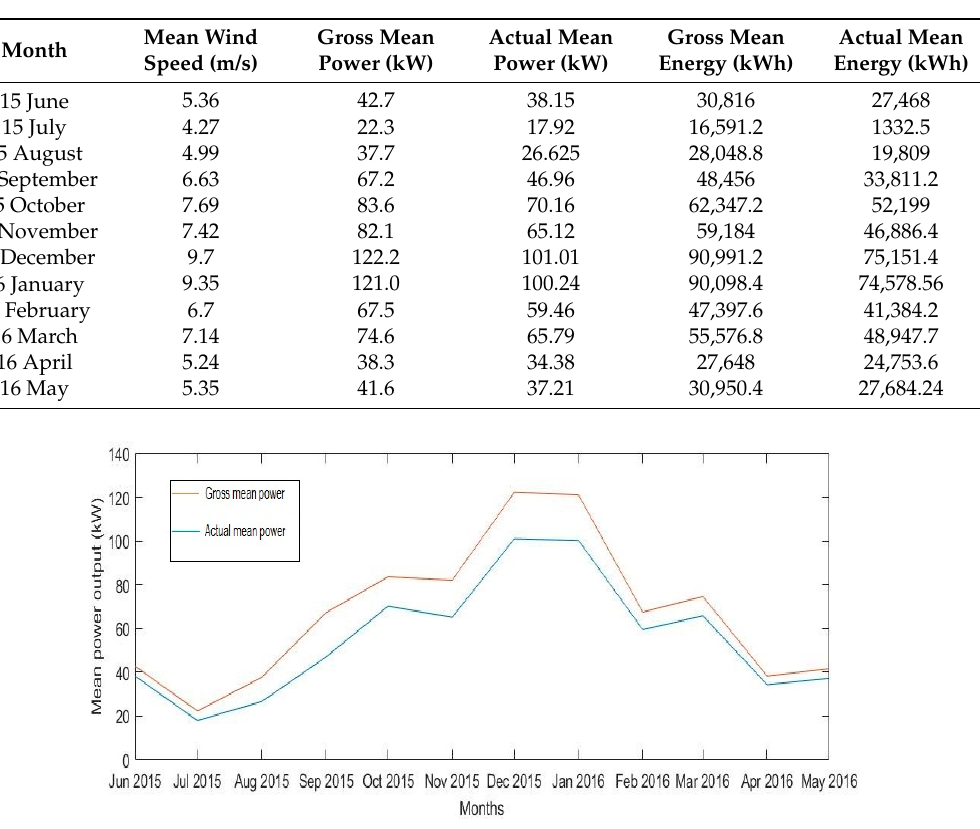
Figure 14. The monthly mean power output of the wind-farm.